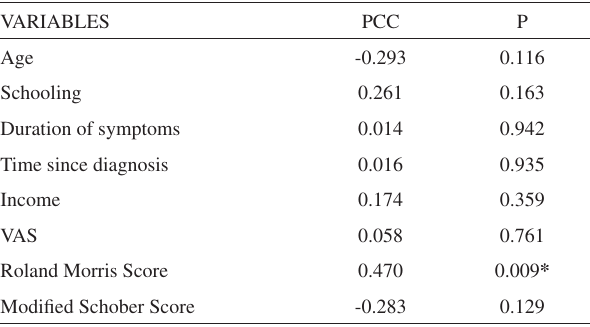
Table 5 - Correlations between GBT score and clinical and demographic variables